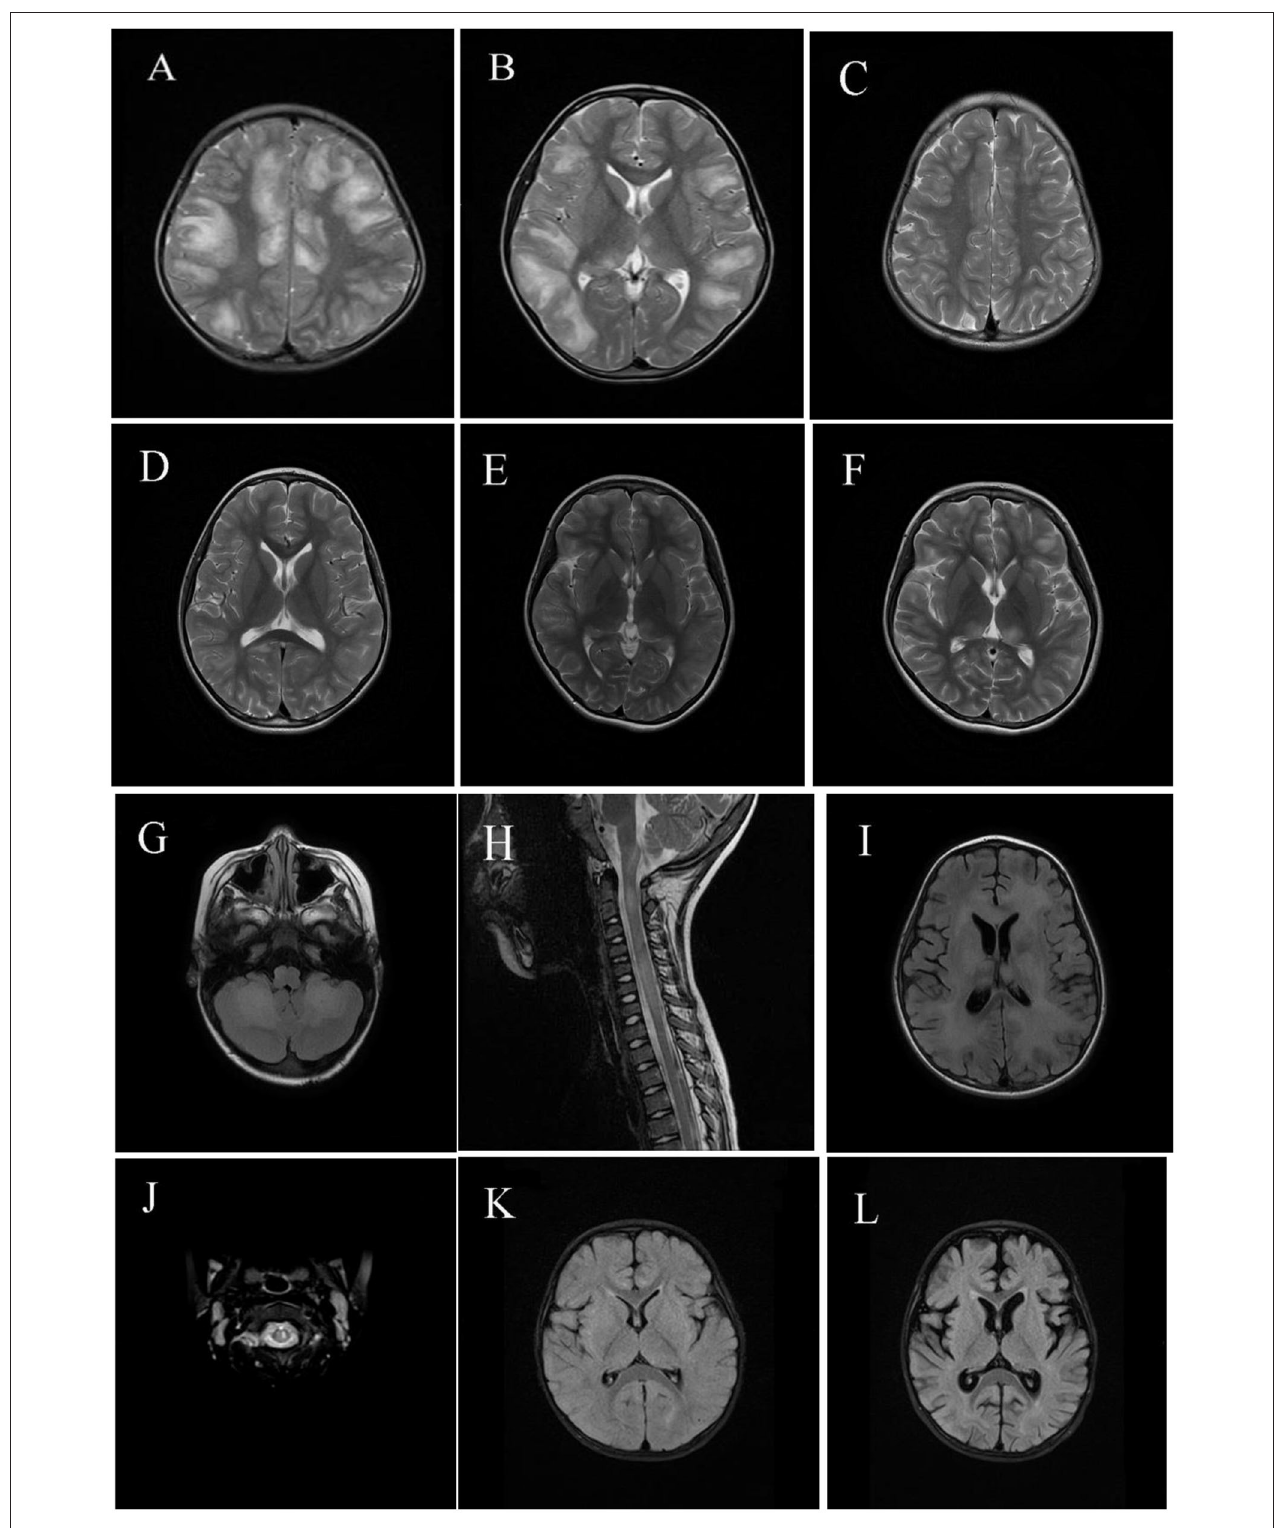
FIGURE 2 | Magnetic resonance imaging (MRI) results of pediatric acute disseminating encephalomyelitis (ADEM) with myelin oligodendrocyte glycoprotein antibodies (MOG-abs). (A–D) Cerebral MRI of a 6-year-old patient with MOG-abs, who presented with fever, headache, projectile vomiting, drowsiness, and ataxia, revealed large and blurred lesions involving both hemispheres [ (A) ; axial-T2)], corpus callosum, thalamus/basal ganglia [ (B) ; axial-T2], brainstem, and cerebellum (not shown).